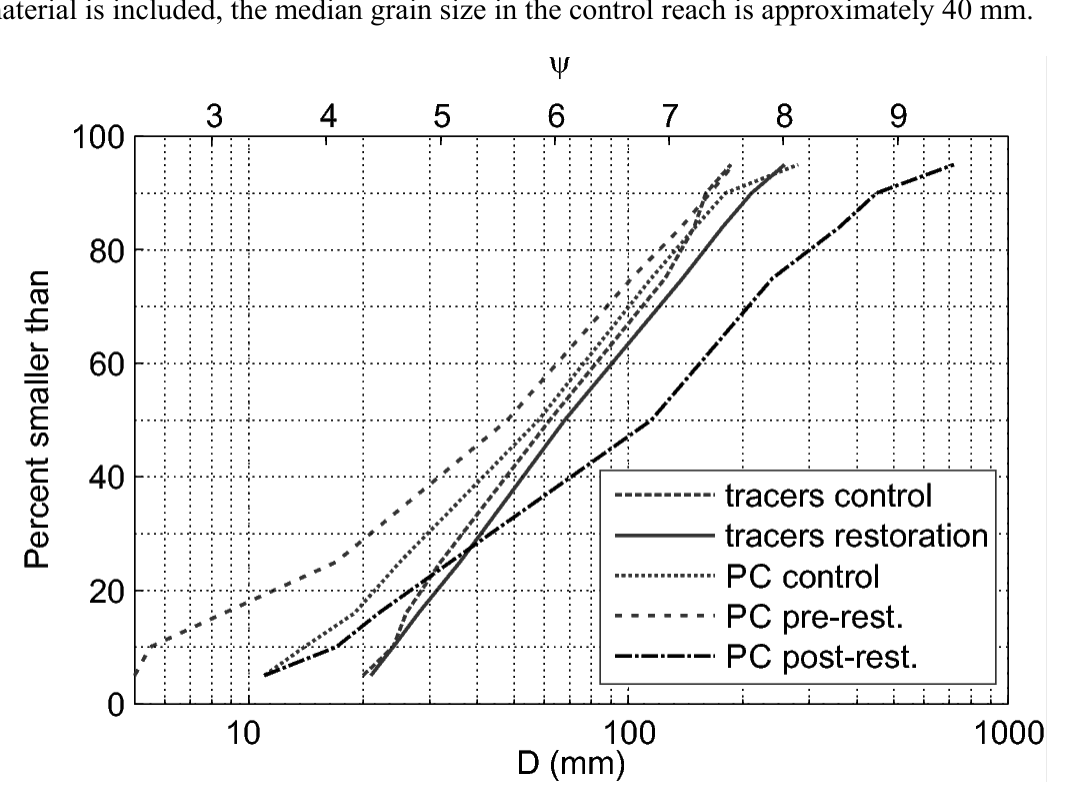
Figure 4. Particle size distributions of tracers populations and bed sediment samples (pebble counts—PC) in the control and restoration reaches. Pre-restoration information was completed by Parish Geomorphic